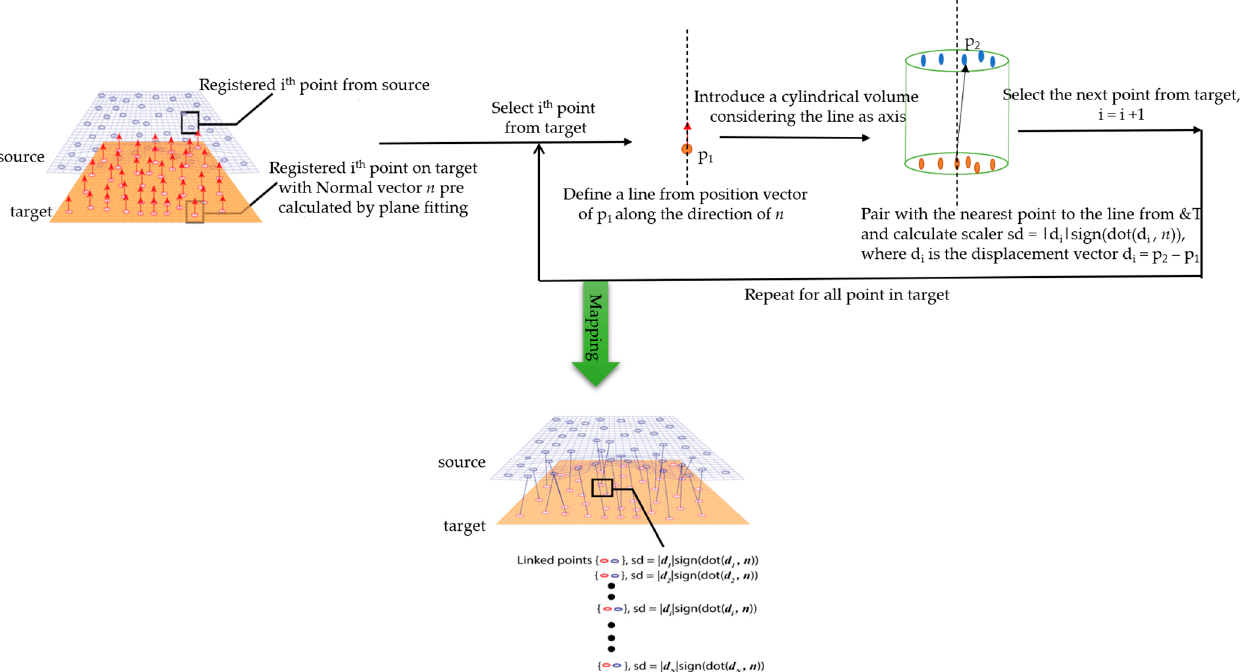
Figure 6. Sketch of the P2P_AlongNV distance calculation.